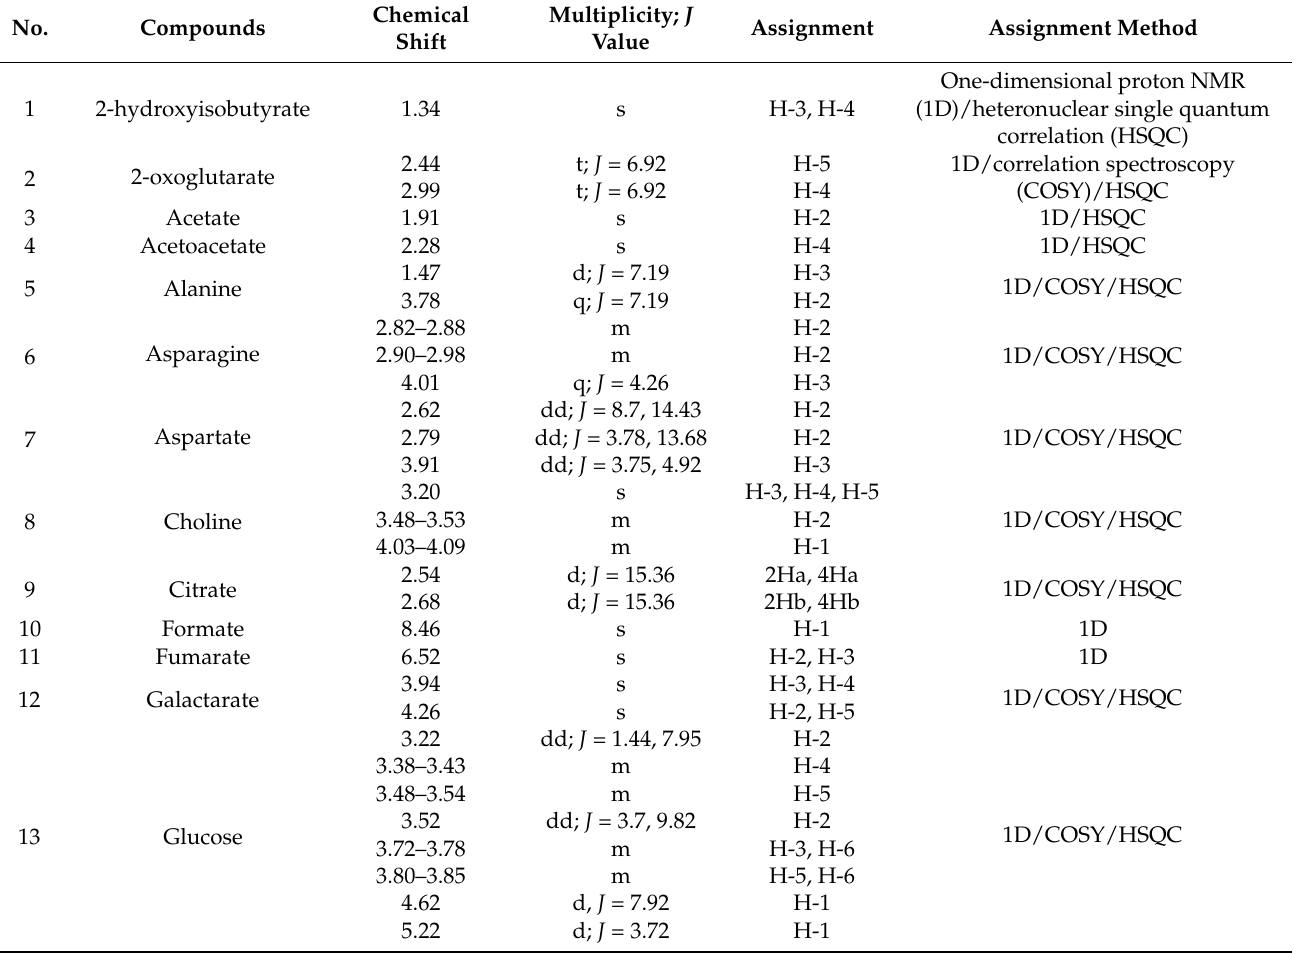
Table 1. Assignment of 1 H-NMR (nuclear magnetic resonance) spectral peaks of soybean